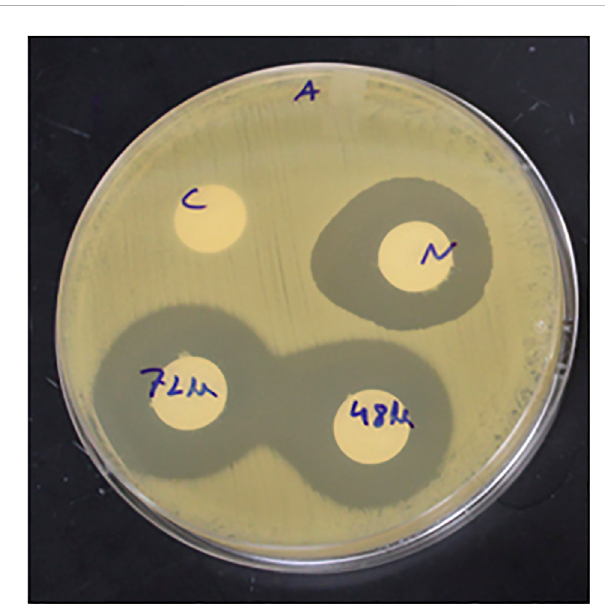
FIGURE 10 Antimicrobialactivityofcellfreesupernatant(CFS)andNisinagainst H. pylori at 48-h and 72-h incubation time points. C- control (sterile water), N- Nisin (1000 IU/mL), 48 h- and 72 h-incubation time point.